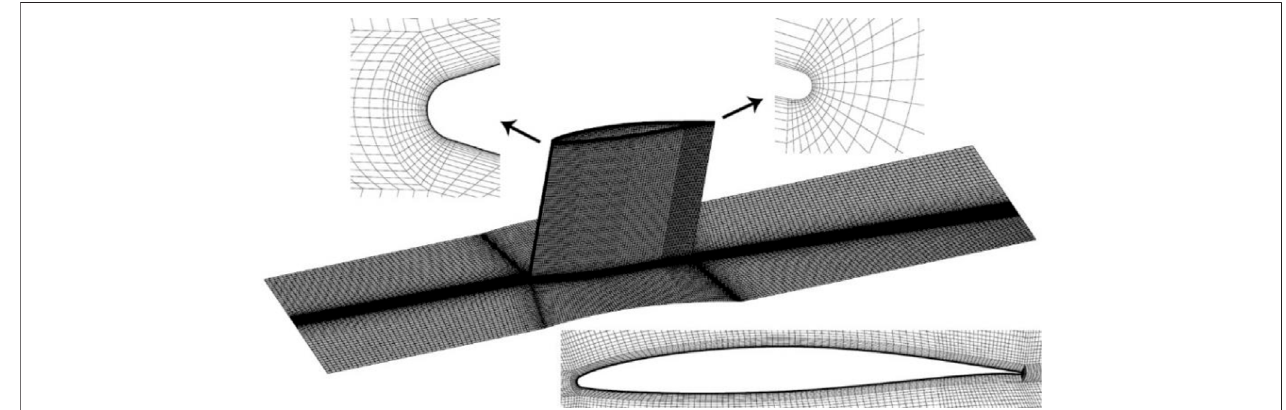
FIGURE 1 | Cascade mesh.